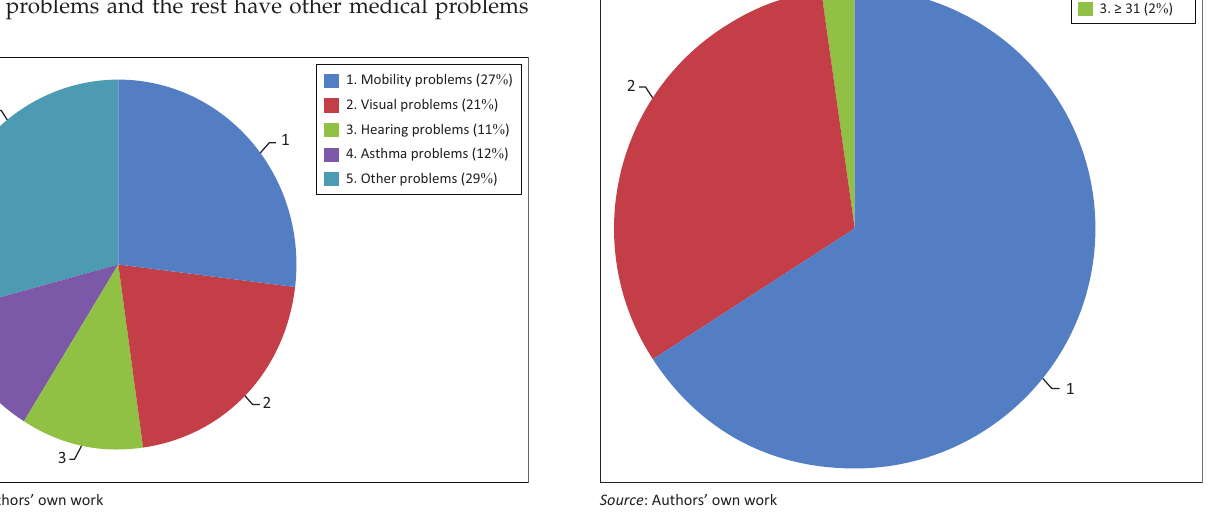
FIGURE 1: Types of disabilities among students of the University of Mauritius.